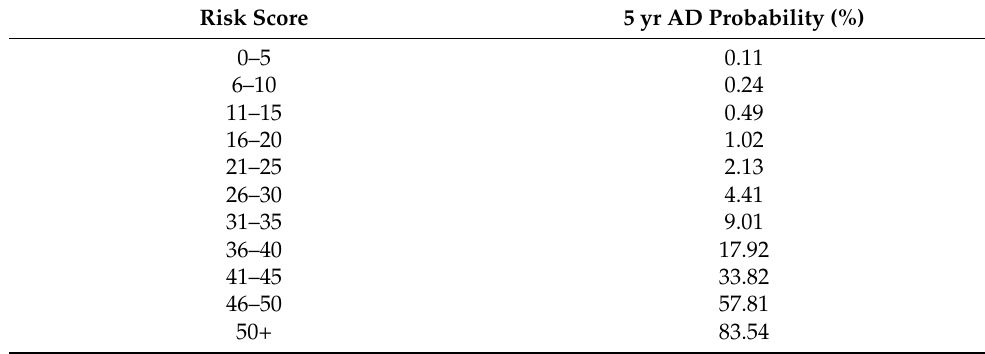
Table 4. Score ranges and probability of AD within 5 years for individuals aged over 65